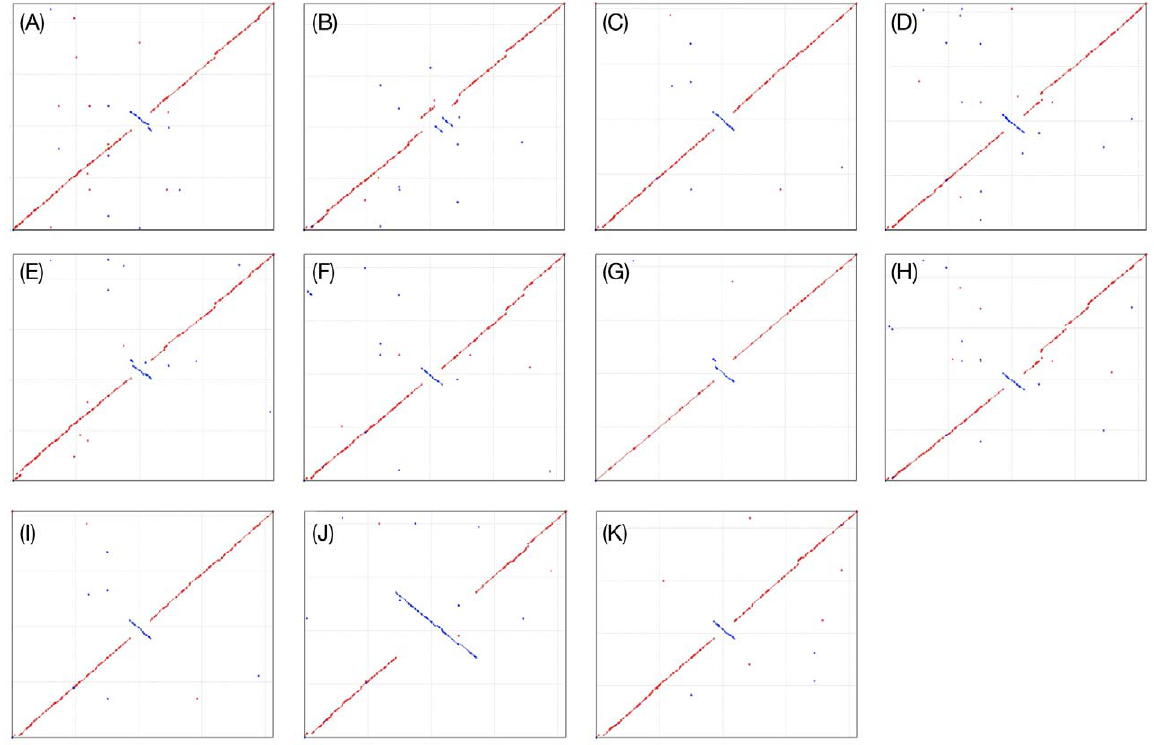
Figure 3. Comparisons of complete pneumococcal genomes to the PNI0373 reference. The eleven fully sequenced pneumococcal genomes were plotted against the PNI0373 genome. Relative to reference genome (PNI0373), the pneumococcal genomes are largely co-linear with minimal rearrangements. As noted, there is an inversion in all compared genomes ranging in size in the region surrounding the terminus of replication, which is often involved in structural variation. PNI0373 was plotted along the x-axis while the query genomes were plotted along the y- axis: (A) 70585; (B) CGSP14; (C) D39; (D) G54; (E) Hungary 19A-6; (F) JJA; (G) P1031; (H) ATTC 700669; (I) R6; (J) Taiwan 19F-14; and (K) TIGR4. Red line: conserved orientation; blue line: inverted orientation.